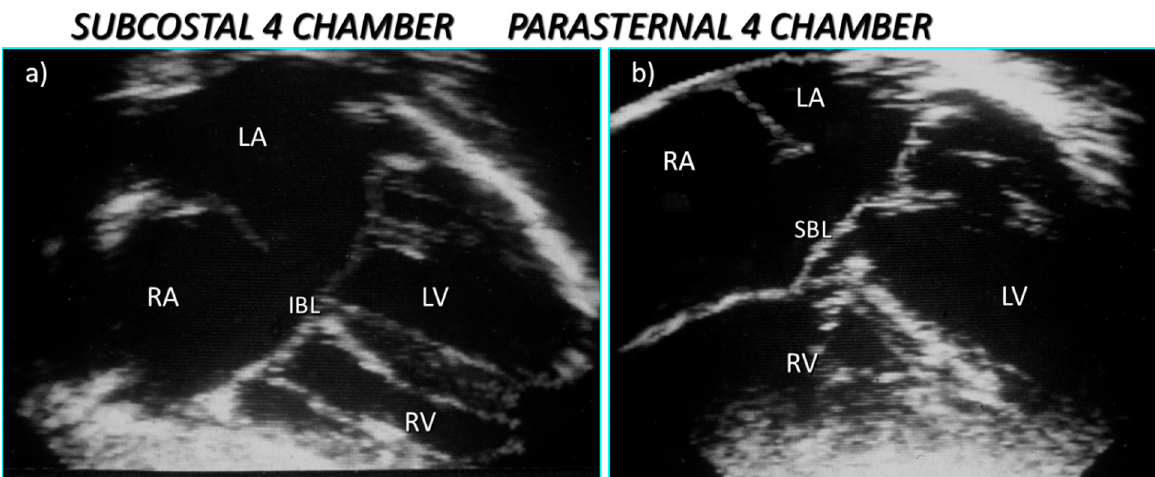
Figure 9. Echocardiography sections from a partial atrioventricular septal defect showing ( a ) the primum defect and inferior bridging leaflet in the subcostal section and ( b ) the anterior and bridging leaflet in the apical section with an obvious recess beneath the superior bridging leaflet.